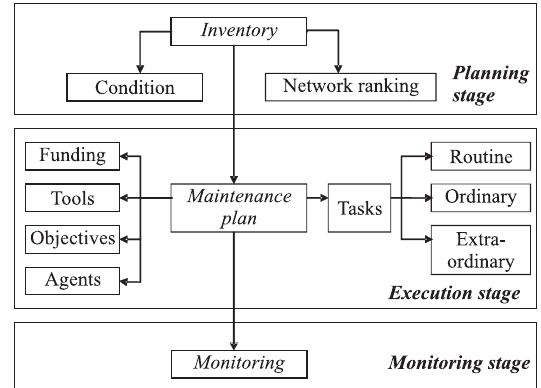
Fig. 3. Proposed low-volume road management